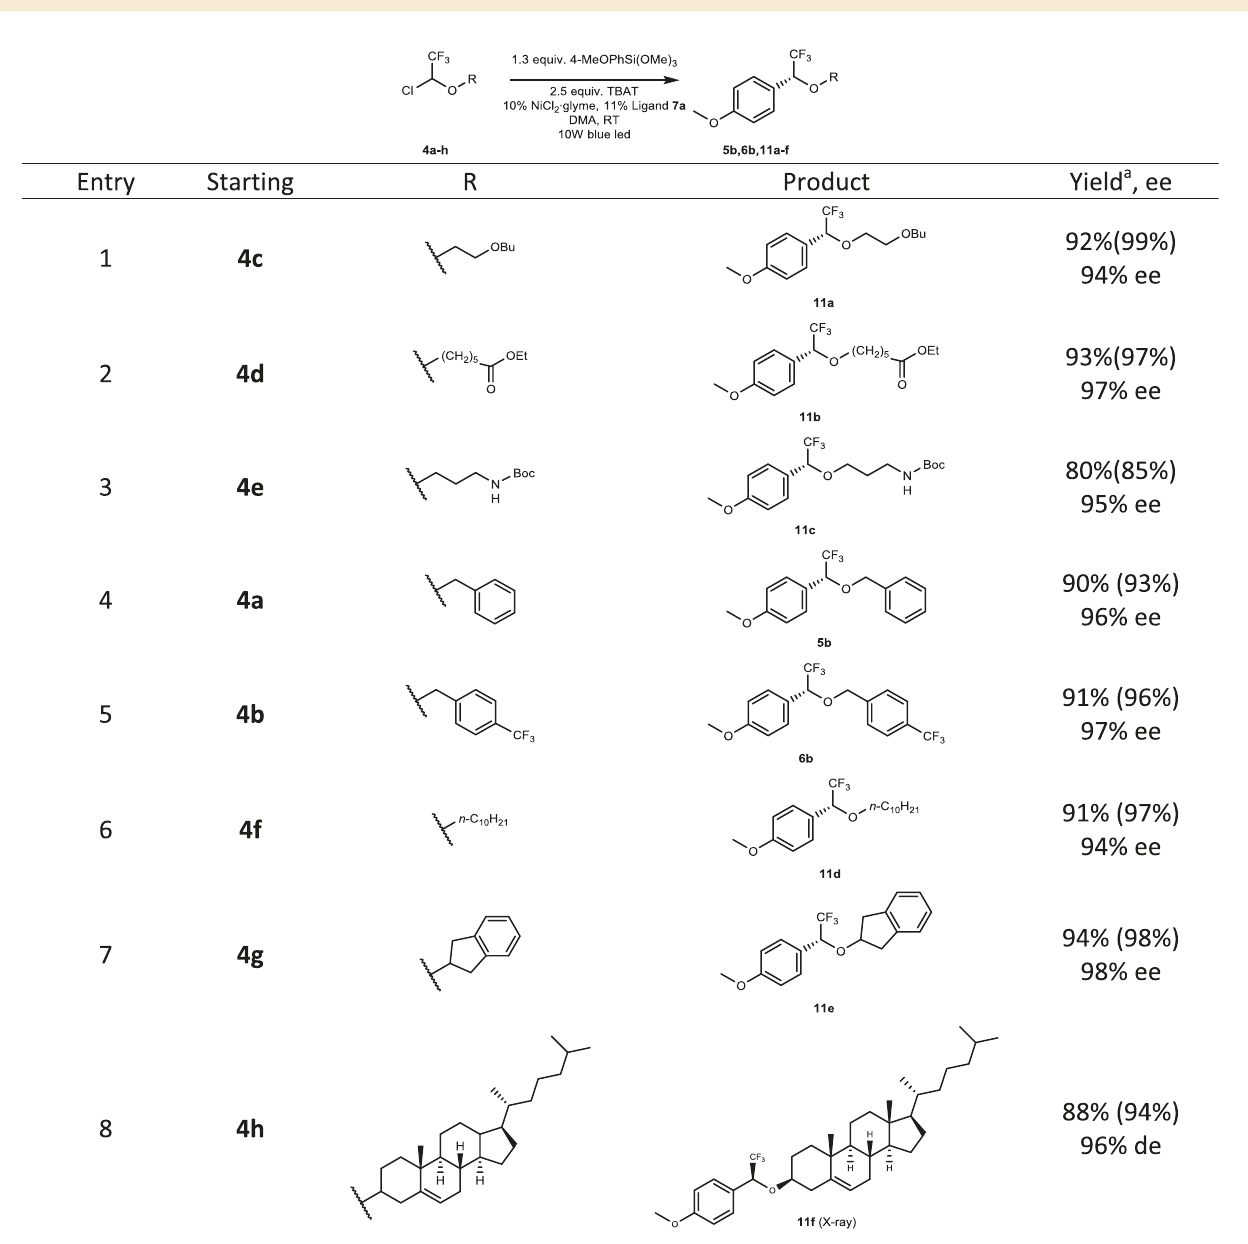
Table 2 Cross-coupling of various